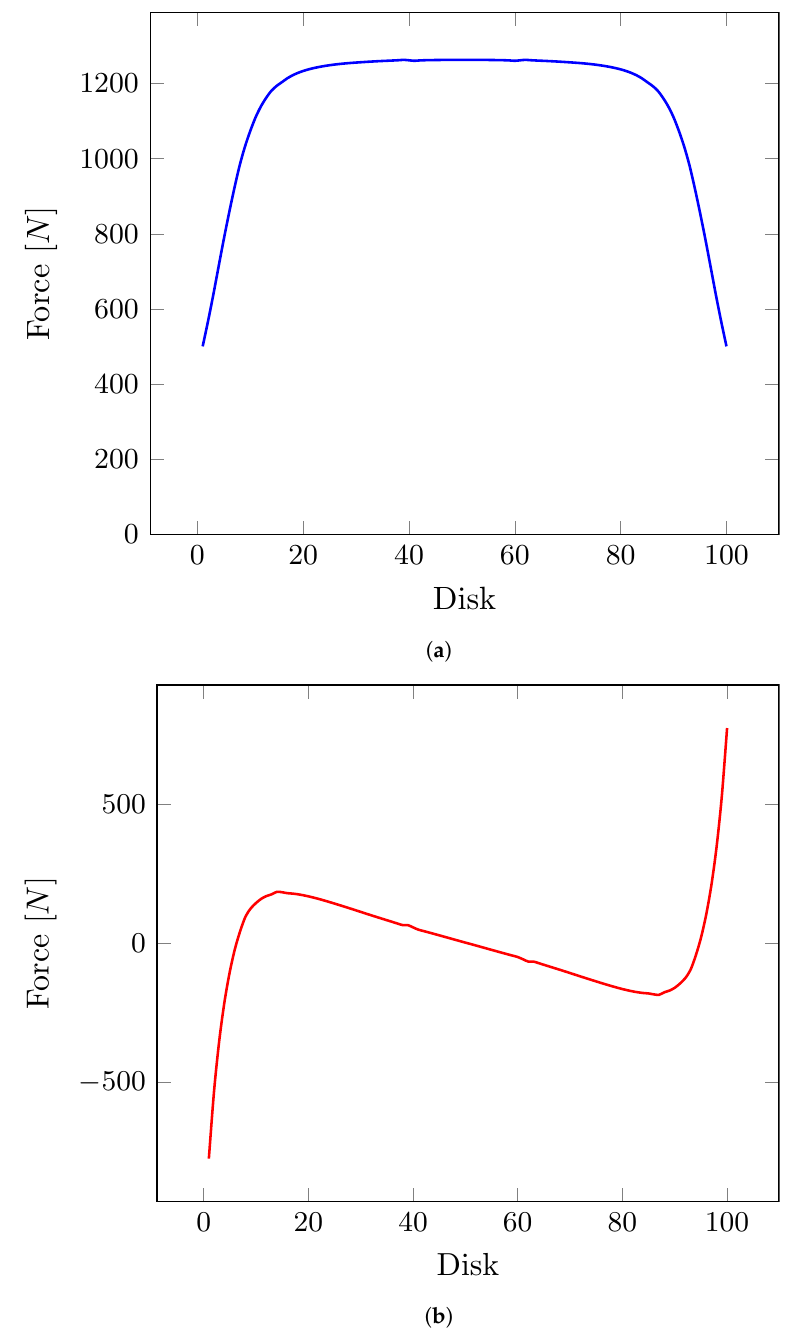
Figure 4. Forces on Phase A low-voltage winding. ( a ) Radial force; ( b ) Axial force. In the high-voltage winding (see Figure 5), the radial forces are negative. They are directed away from the core. The axial forces have similar behavior to the low-voltage radial forces, which means that they point towards the middle of the